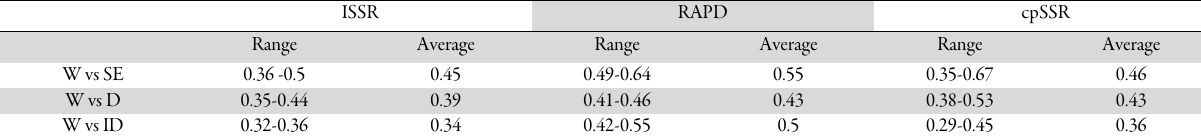
Table 7. Jaccard’s similarity coefficient range between wild plants (W) and in vitro regenerated plants SE=somatic embryogenesis, D= direct, ID= indirect organogenesis)